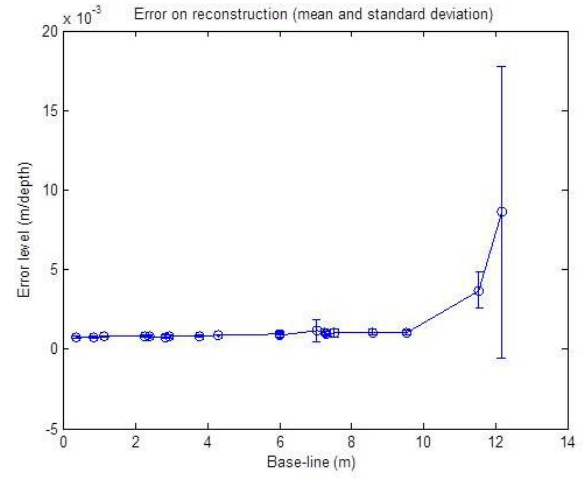
Figure 10. Reconstruction error with respect to the baseline with a noise level corresponding to ± 2 p, ± 2 ◦ for α and ± 2 cm for r . The error is in meters relative to the point depths ( r ). The mean and standard deviation over 50 reconstructed points are